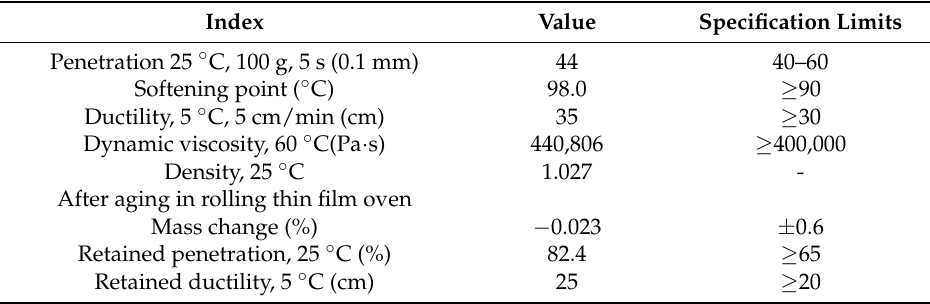
Table 3. Properties of high viscosity modified